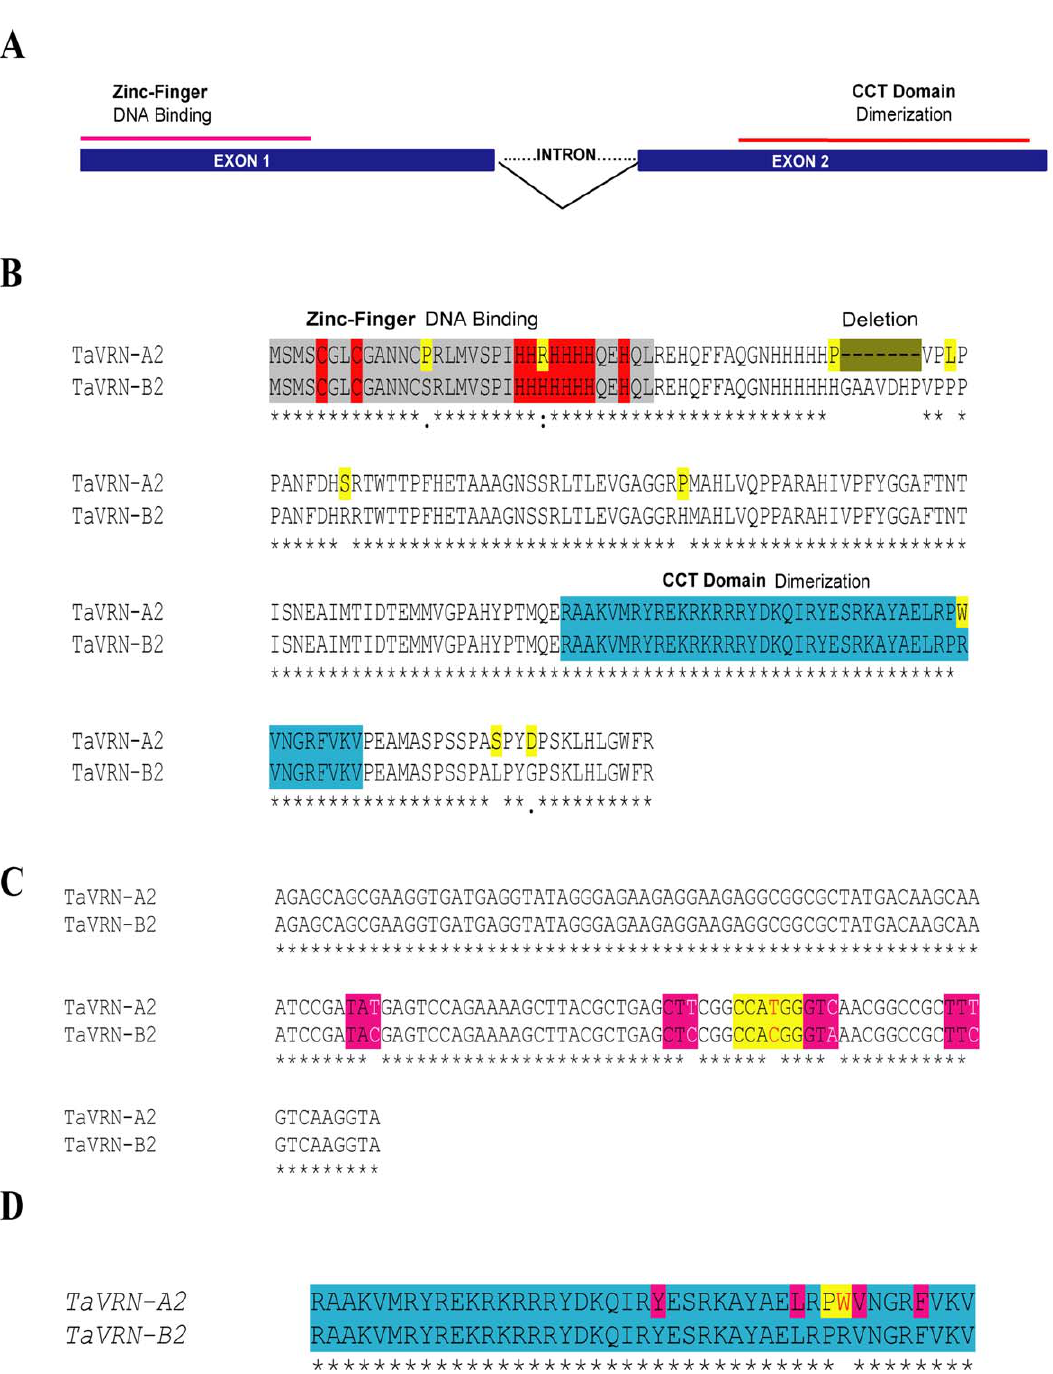
Figure 1. TaVRN2 structure analysis. A) Gene structure showing the two exons and one intron. Exon1 contains the zinc finger domain and exon2 contains the CCT domain. B) The alignment of TaVRN-A2 and TaVRN-B2 proteins. Regions of putative zinc finger highlighted in red, CCT domains highlighted in blue and difference of nine amino acids highlighted in yellow. C) The alignment of CCT domain of the two copies of TaVRN2 showing their different SNPs (in white and red). The sequence highlighted in yellow in the TaVRN-A2 corresponds to NcoI restriction site. D) Proteins alignment of CCT domain, Alignments are done by using Clustal W program from the web.